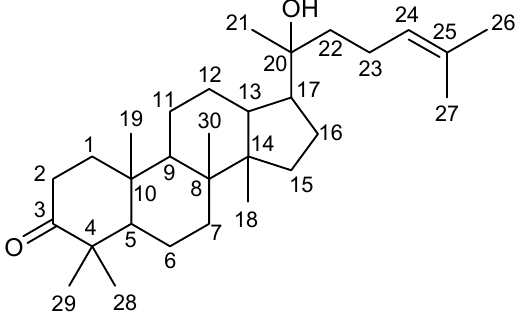
Figure 1. Structure of dipterocarpol isolated from oleo-resin.